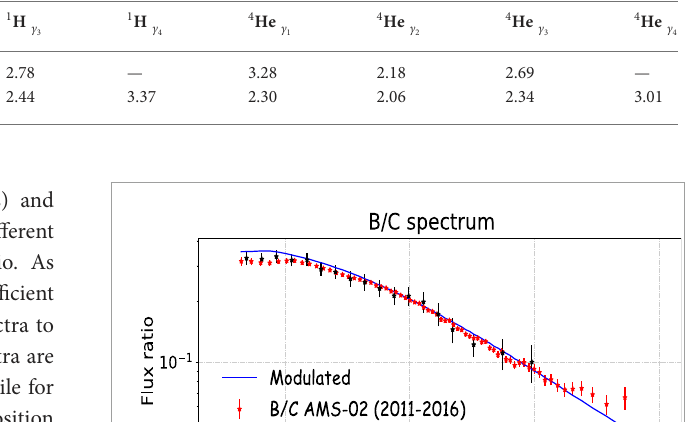
FIGURE 2 Boron-over-carbon spectrum predicted by the γ - optimized model at Earth position ( ∼ 8 . 3 kpc from the galactic centre), compared to experimental data from Pamela and AMS-02.